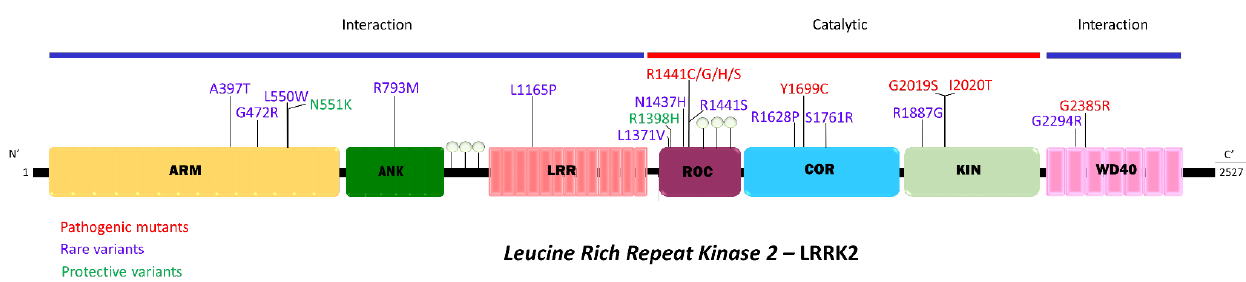
Figure 1. Diagrammatic representation of Leucine Rich repeat Kinase 2 (LRRK2). Depicted are the functional domains of LRRK2. Different variants are indicated in different colors, including pathogenic variants (red), rare variants potentially pathogenic (purple), and protective variants (green). ARM, armadillo repeat domain; ANK, ankyrin repeat domain; LRR, leucine-rich repeat domain; ROC, Ras of complex proteins domain; COR, C-terminal of ROC domain; KIN, kinase domain; WD40, WD40 repeat domain.